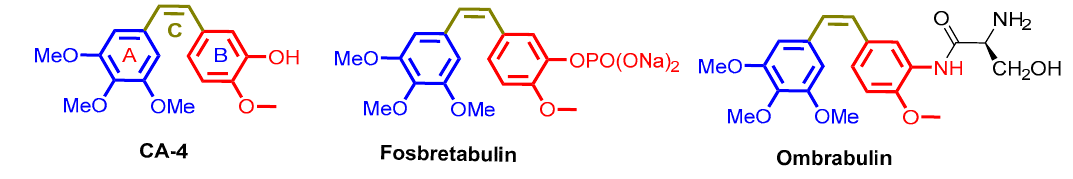
Figure 1. CA-4 and structurally related analogues.